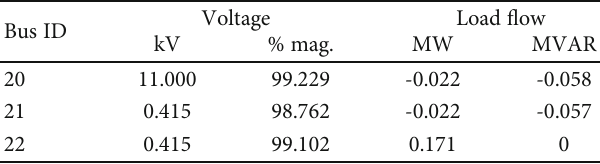
Table 15: Branch losses comparison for all